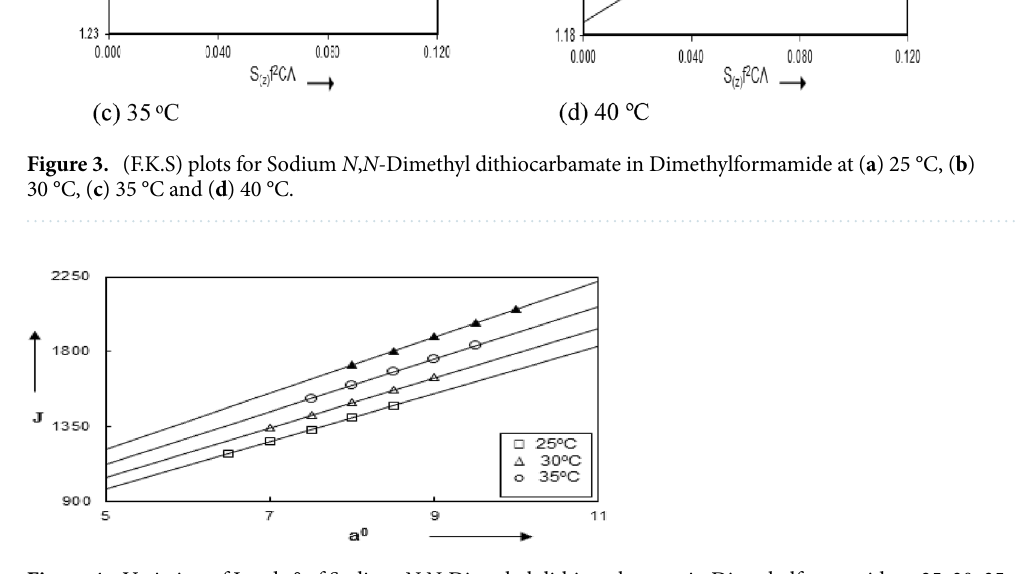
Figure 4. Variation of J and a° of Sodium N , N -Dimethyl dithiocarbamate in Dimethylformamide at 25, 30, 35 and 40 °C.